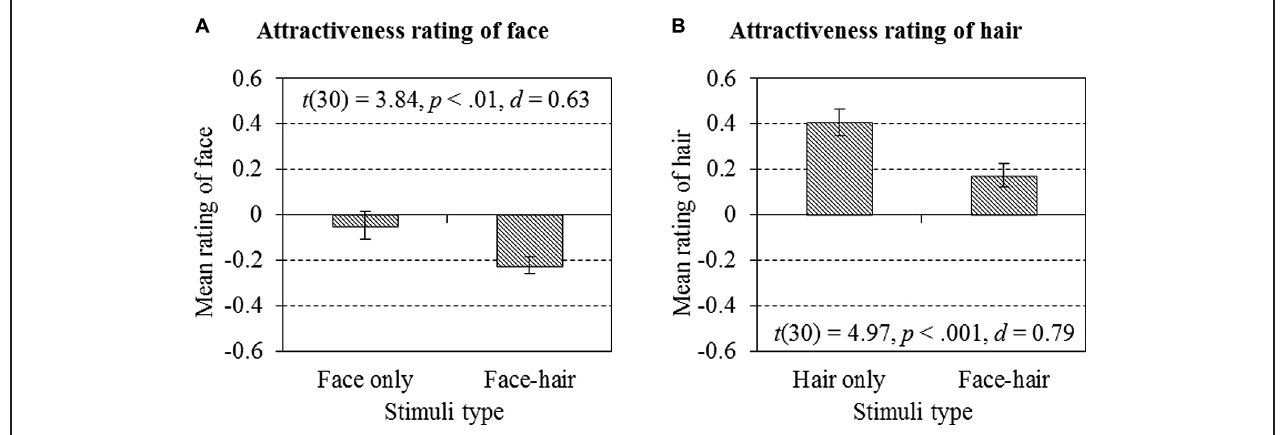
FIGURE 3 | Differences in attractiveness rating of faces when evaluating face-only stimuli and in evaluating face–hair composites (A), and differences in attractiveness rating of hairstyles when evaluating hair-only stimuli and face–hair composites (B). In both cases, the ratings